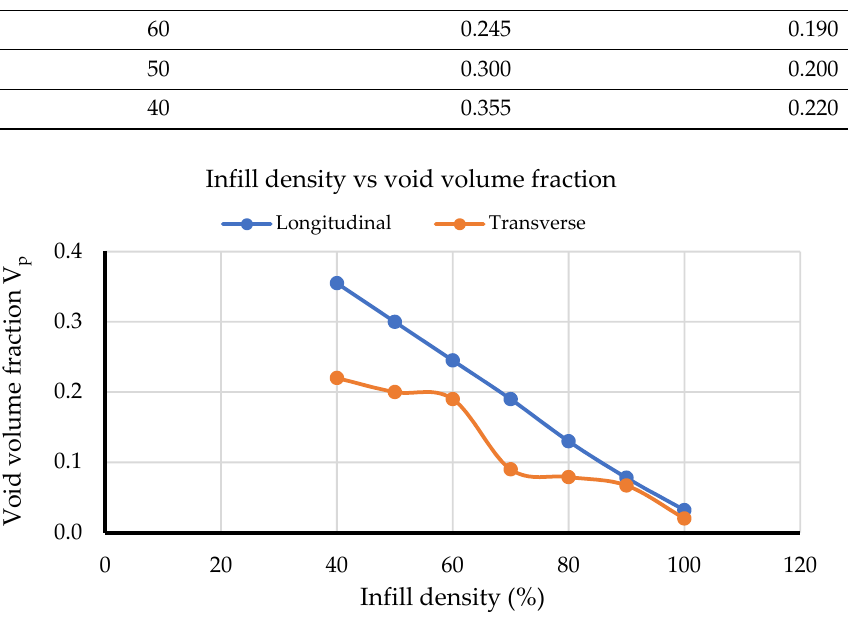
Figure 6. Infill density vs. void volume fraction.